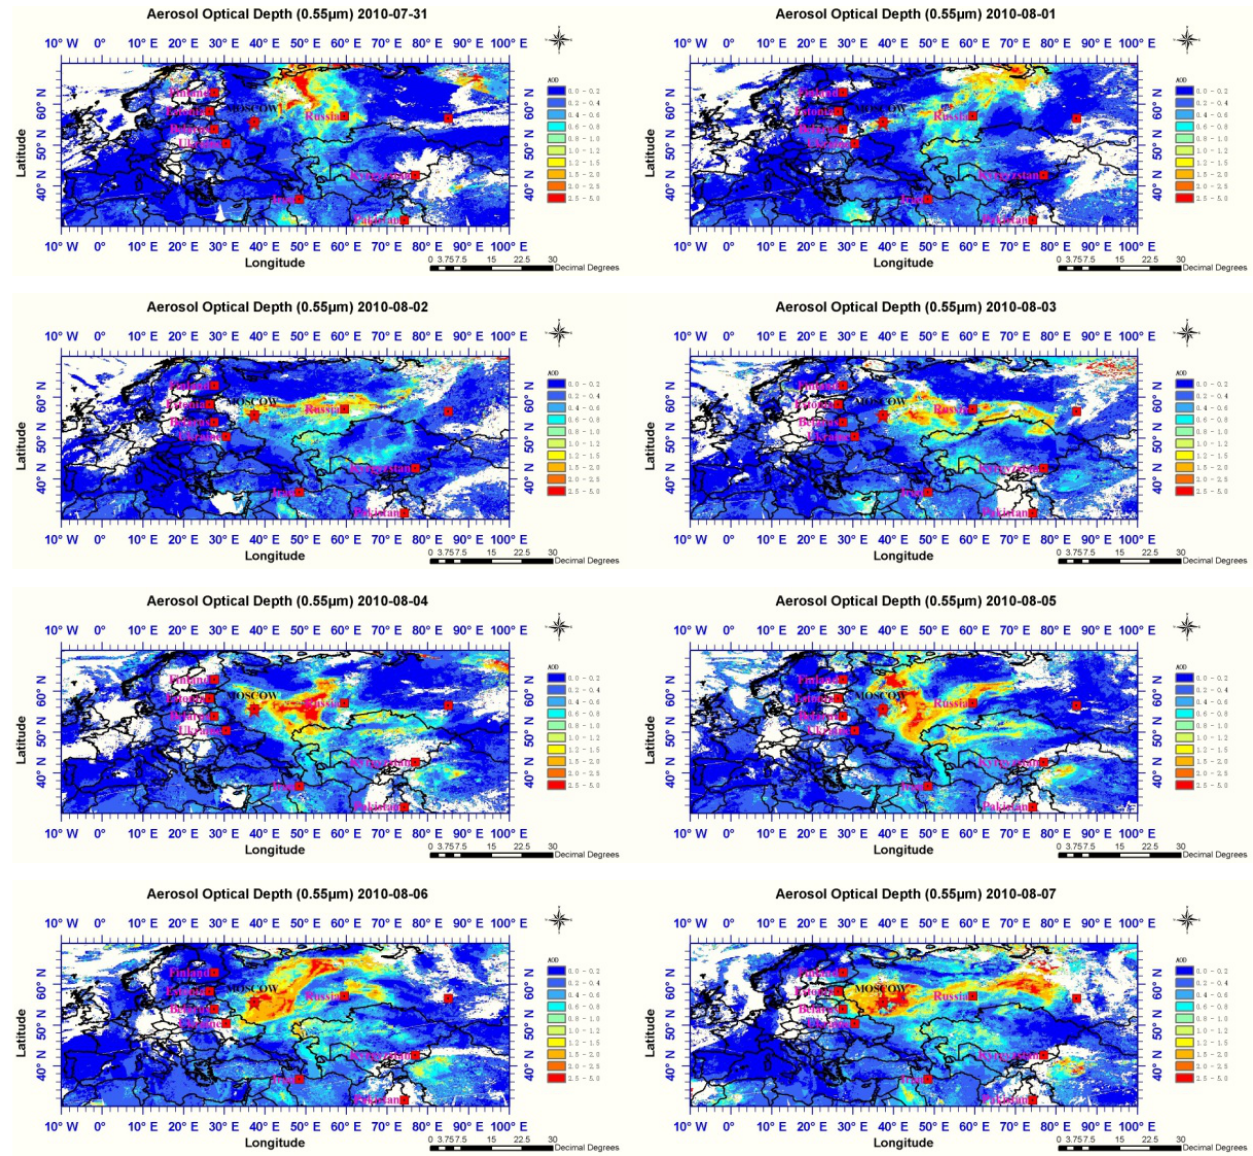
Fig. 4 AOD (at 0.55µm) distribution over the study area for the period from 31 July to 15 August 2010. The AOD was obtained from integration of the AOD retrieved from three different methods as described in the